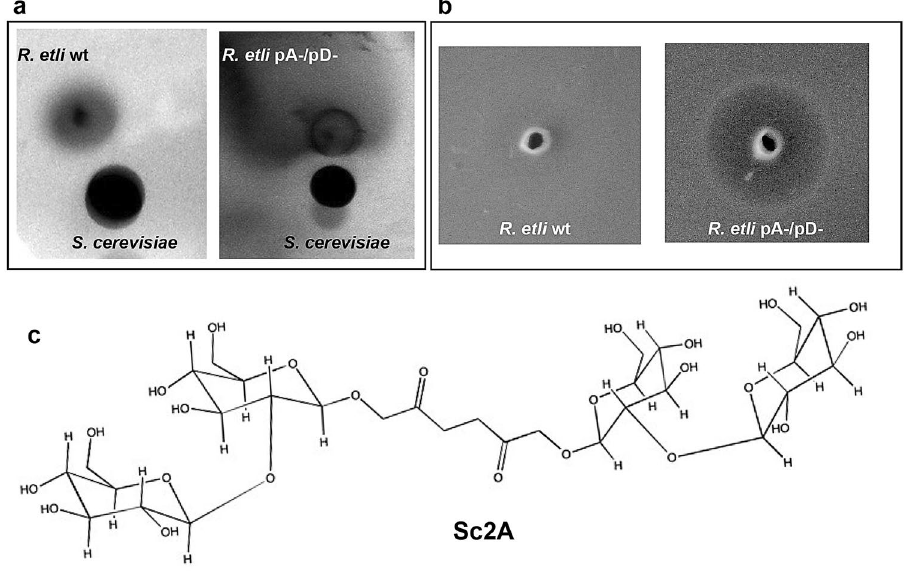
Figure 4. S. cerevisiae s1278B produces a small molecule that only affects the growth of R. etli strains that do not harbor the symbiotic plasmid and plasmid A. ( a ) S. cerevisiae and R. etli strains were inoculated in close proximity onto MMD soft agar. R. etli pA-/pD- grew, forming a swarm far from the yeast colony. ( b ) Inhibition of R. etli pA-/pD- growth by 5 µg/mL of a purified compound from the yeast supernatant, which we named Sc2A. ( c ) Proposed molecular structure of